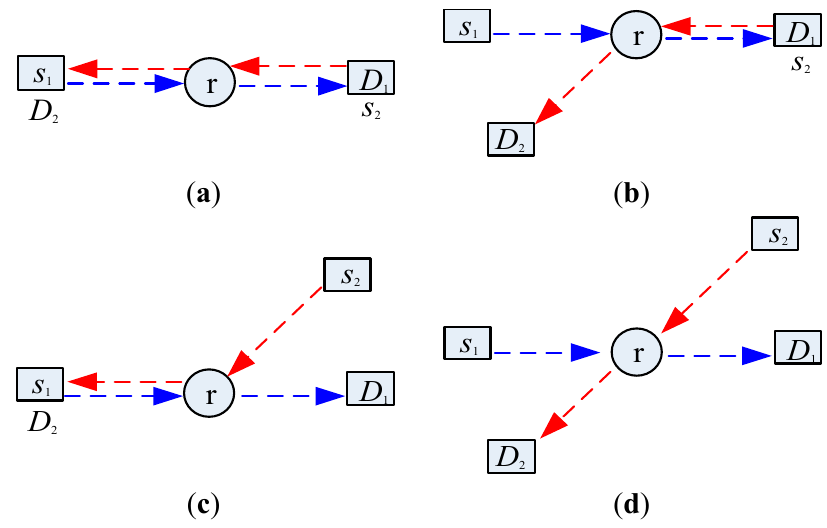
Figure3. ( a ) Illustration of situation in Case One; ( b ) Illustration of situation in Case Two; ( c ) Illustration of situation in Case Three; ( d ) Illustration of situation in Case Four.